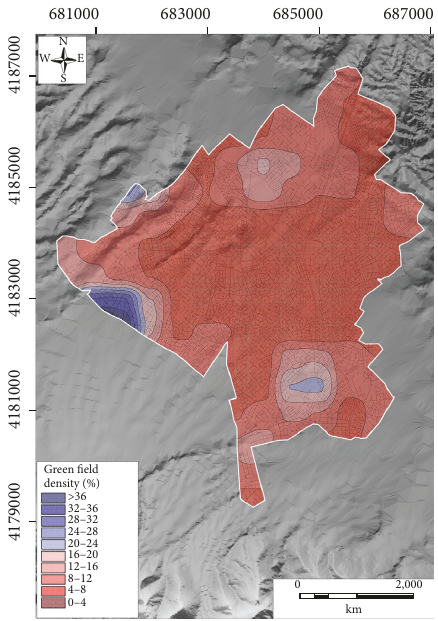
Figure 5: Green field density